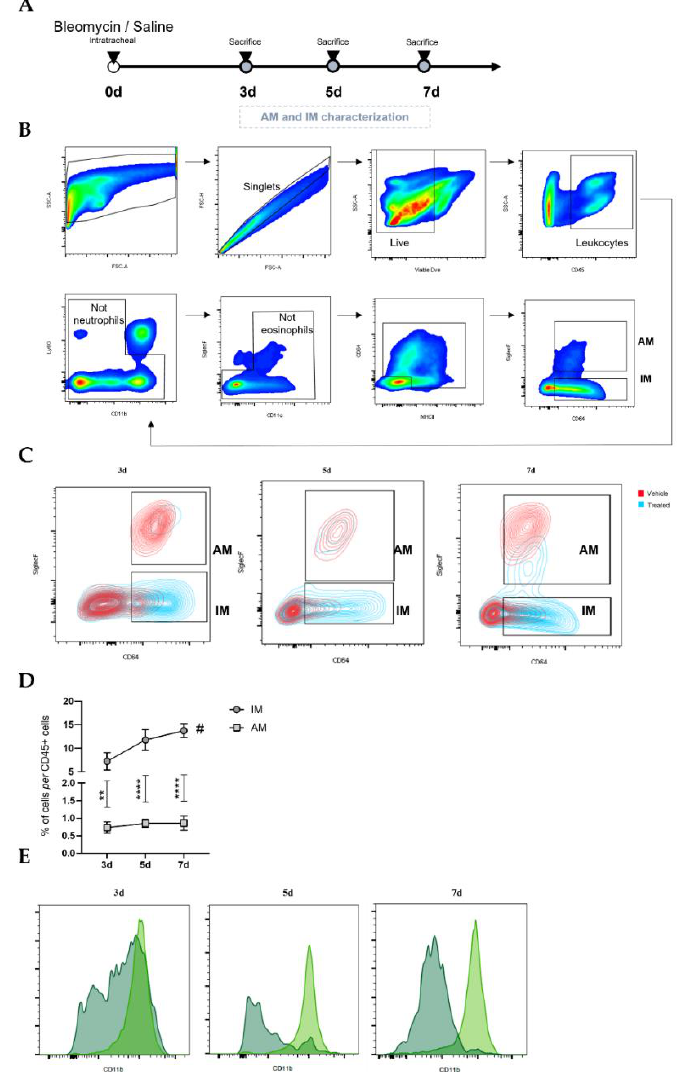
Figure 1. Macrophage populations in the lung during the inflammatory phase of BLM-induced pulmonary fibrosis mouse model. ( A ) Intratracheal injection of BLM or saline was performed on day 0. Animals were sacrificed on days 3, 5, and 7 to quantify macrophage populations. ( B ) Gating strategy for the identification of AM and IM in lung samples by flow cytometry. ( C ) Representative plots of proportions of AM and IM in untreated (red) and BLM-treated (blue) lungs at days 3, 5, and 7. ( D ) Proportion of IM and AM in BLM-treated animals at days 3, 5, and 7. The percentage of cells in live CD45+ is plotted. ( E ) Profile of CD11b expression in IM (light green) and AM (dark green) on BLM-induced PF mice at days 3, 5, and 7. Data are shown as the mean ± SEM of one representative experiment of three independent experiments. ** p < 0.01, **** p < 0.0001: treated IM vs. treated AM. # p < 0.05: different time points. IM: interstitial macrophages; AM: alveolar macrophages; d: days post intratracheal BLM